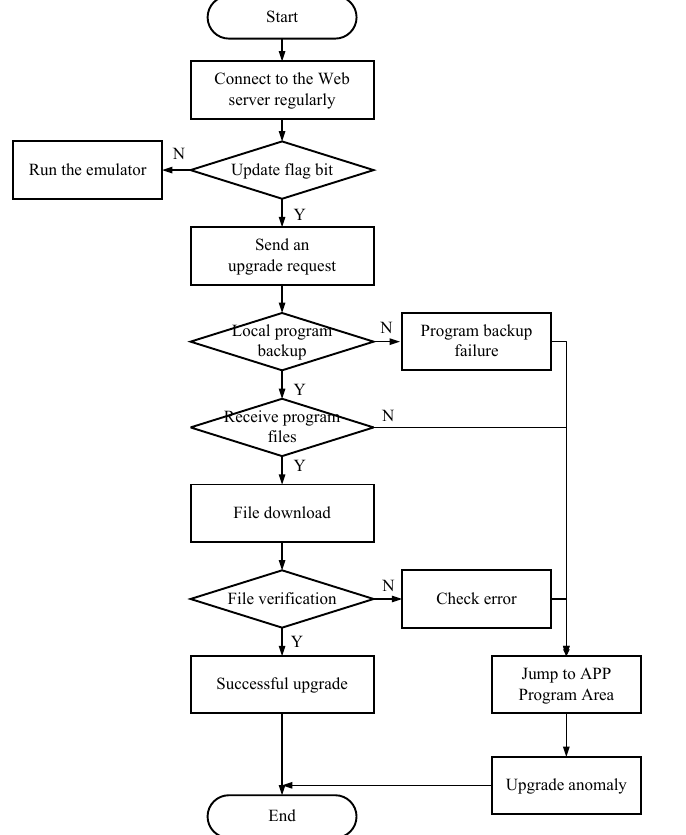
Figure 6. Flow chart of firmware